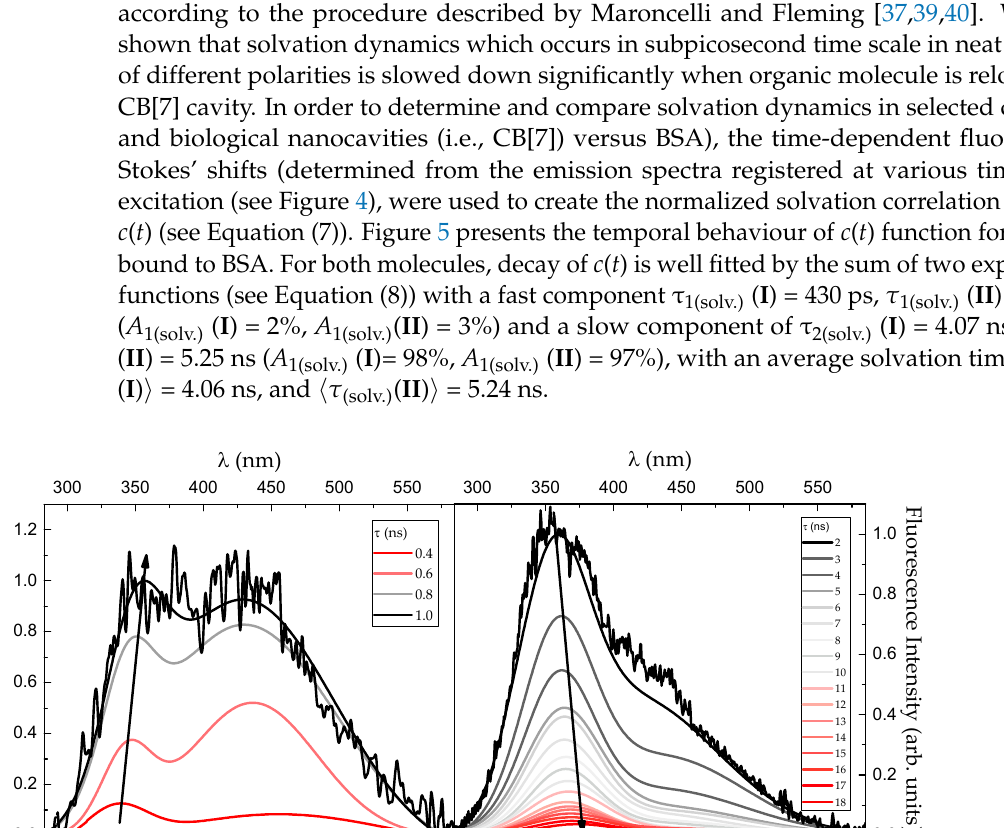
Figure 3. Fluorescence decay profiles of I ( A ) and II ( B ) in absence and different concentration of BSA (0.0 M, 0.1x10 − 5 M, 0.2x10 − 5 M, 0.4x10 − 5 M, 0.6x10 − 5 M, 0.8x10 − 5 M, 1.4x10 − 5 M, 2.0x10 − 5 M).